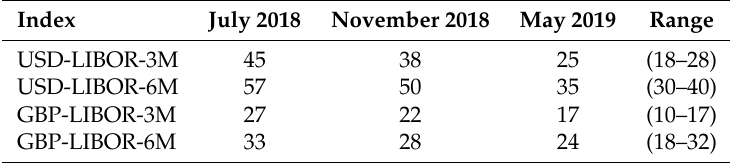
Table 1. Spread between the different LIBOR indices and overnight composition. The spreads at the different dates are the market spreads for 30-year tenor basis swaps similar to those reported in Figure 5 for USD-LIBOR-3M. The ranges represent the author’s estimates for the different